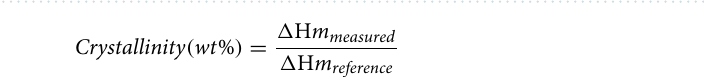
Figure 8. Crystal weight (%) for ( a ) the polypropylene component and ( b ) polyamide-12 component of the AAA backsheet samples. Error bars represent 2 standard